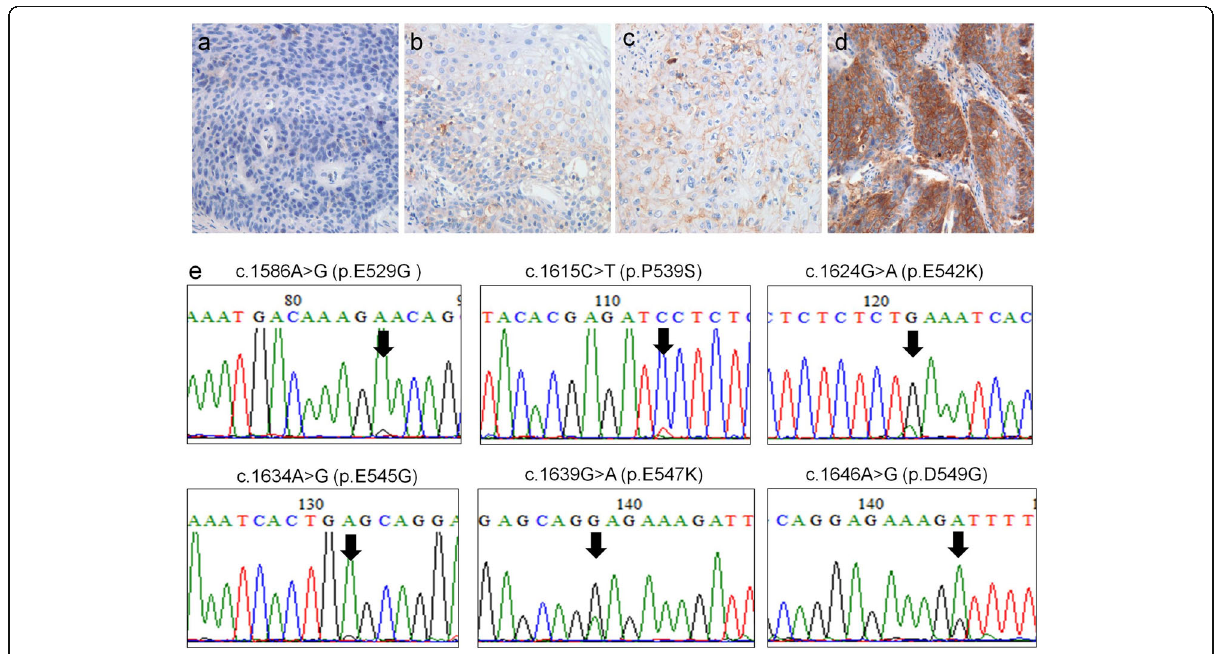
Fig. 1 Representative immunohistochemical images of PD-L1 expression in esophageal squamous cell carcinoma. PD-L1 expression was scored from 0 ( a ), 1+ ( b ), 2+ ( c ), to 3+ ( d ). Cases with scores of 0 were considered PD-L1-negative, while cases with scores ≥ 1+ were considered positive for PD-L1 expression. ( e ) Electropherograms of the mutated sequences in exon 9 of PIK3CA gene. (Original magnification, ×